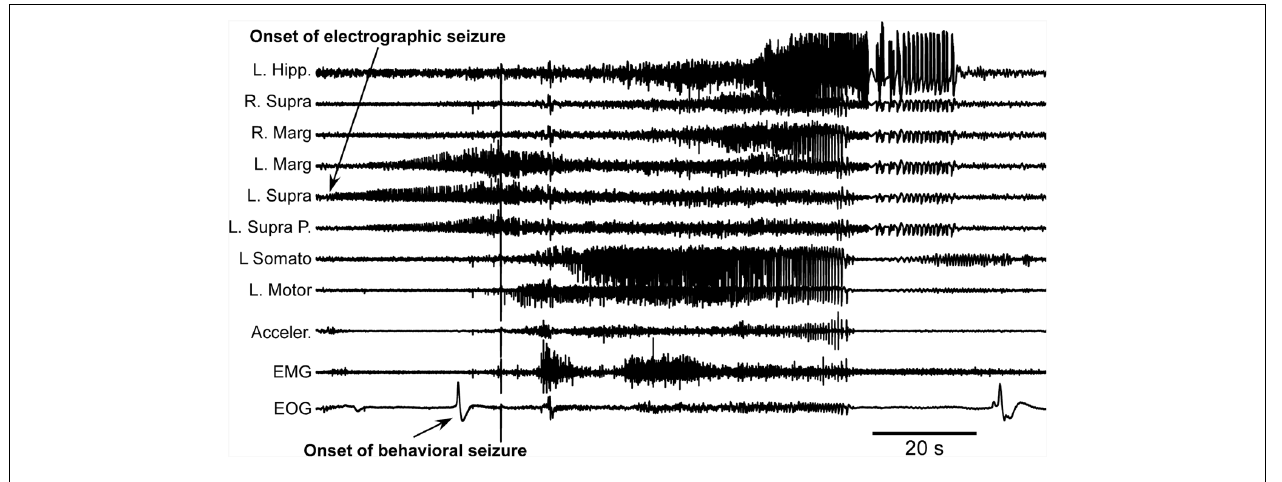
occurs when motor cortex displays electrographic seizure. L, left; R, right; P, posterior; Hipp, hippocampus; Supra, suprasylvian gyrus; Marg, marginal gyrus; Somato, somatosensory cortex; Motor, motor cortex; Acceler, accelerometer; EMG, electromyogram; EOG,